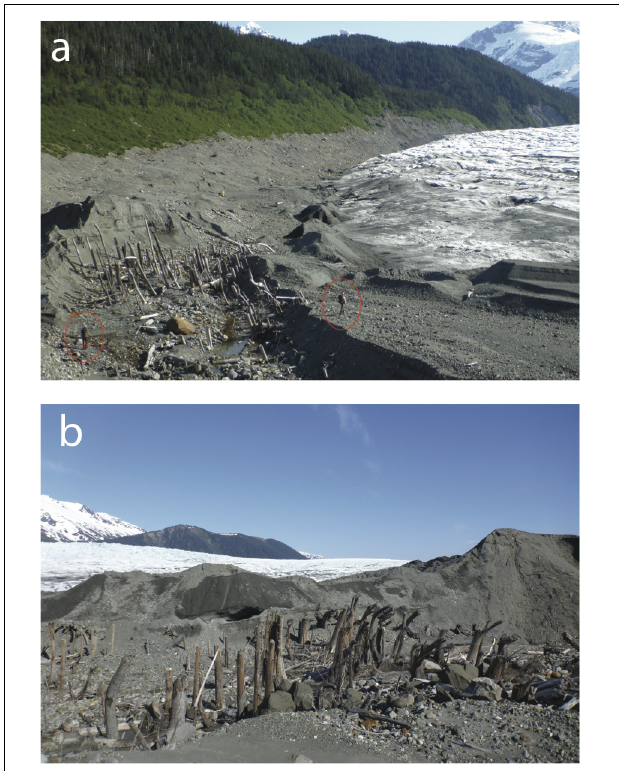
FIGURE 2 | (a) The La Perouse Glacier in retreat in 2016 exposing an in situ interstadial forest. Humans (circled) for scale. (b) These trees were covered by glacial outwash deposited as the glacier advanced. Tree trunks were sheared off by the glacier where they protruded above the protective outwash gravel. Note the flagged logs pointing in the direction of glacier